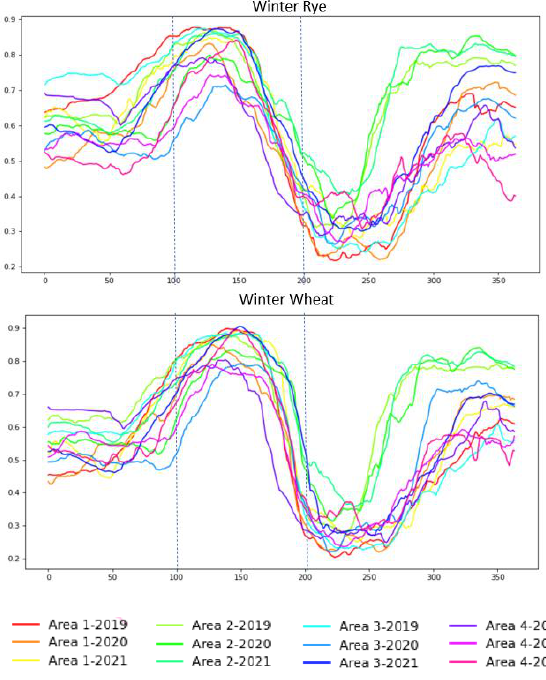
Figure 8. The average NDVI times series of winter barley and winter wheat for each different area and different